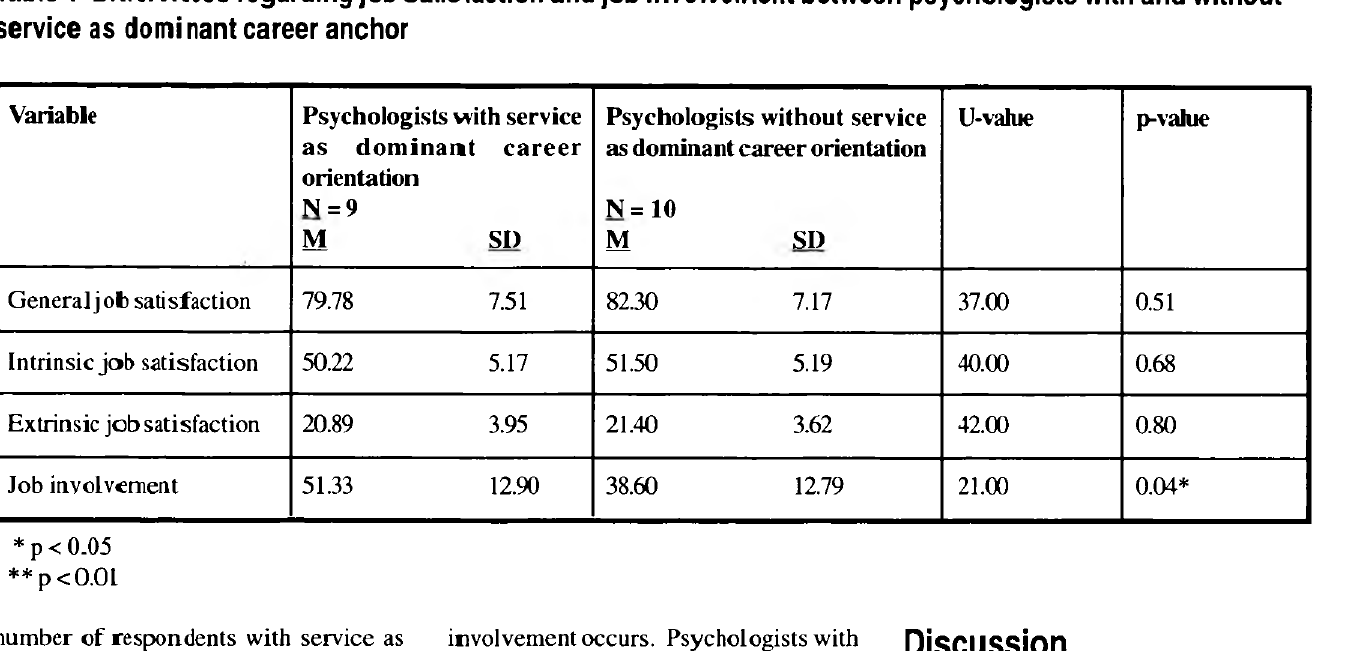
Table 1 Differences regarding job satisfaction and job involvement between psychologists with and